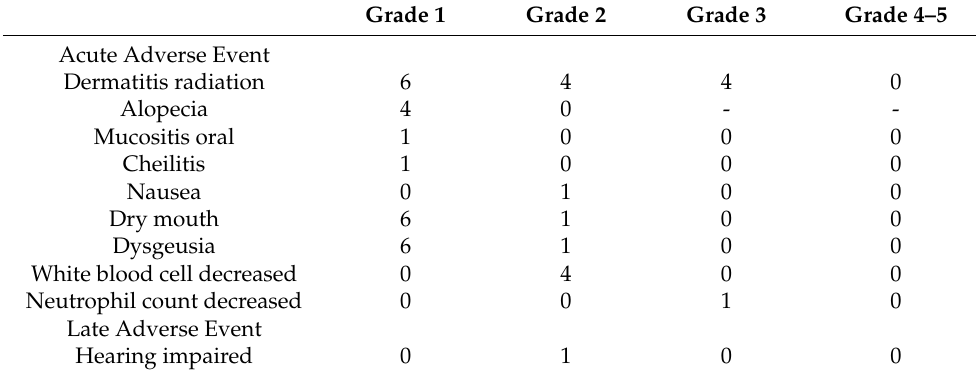
Table 4. Numbers of adverse